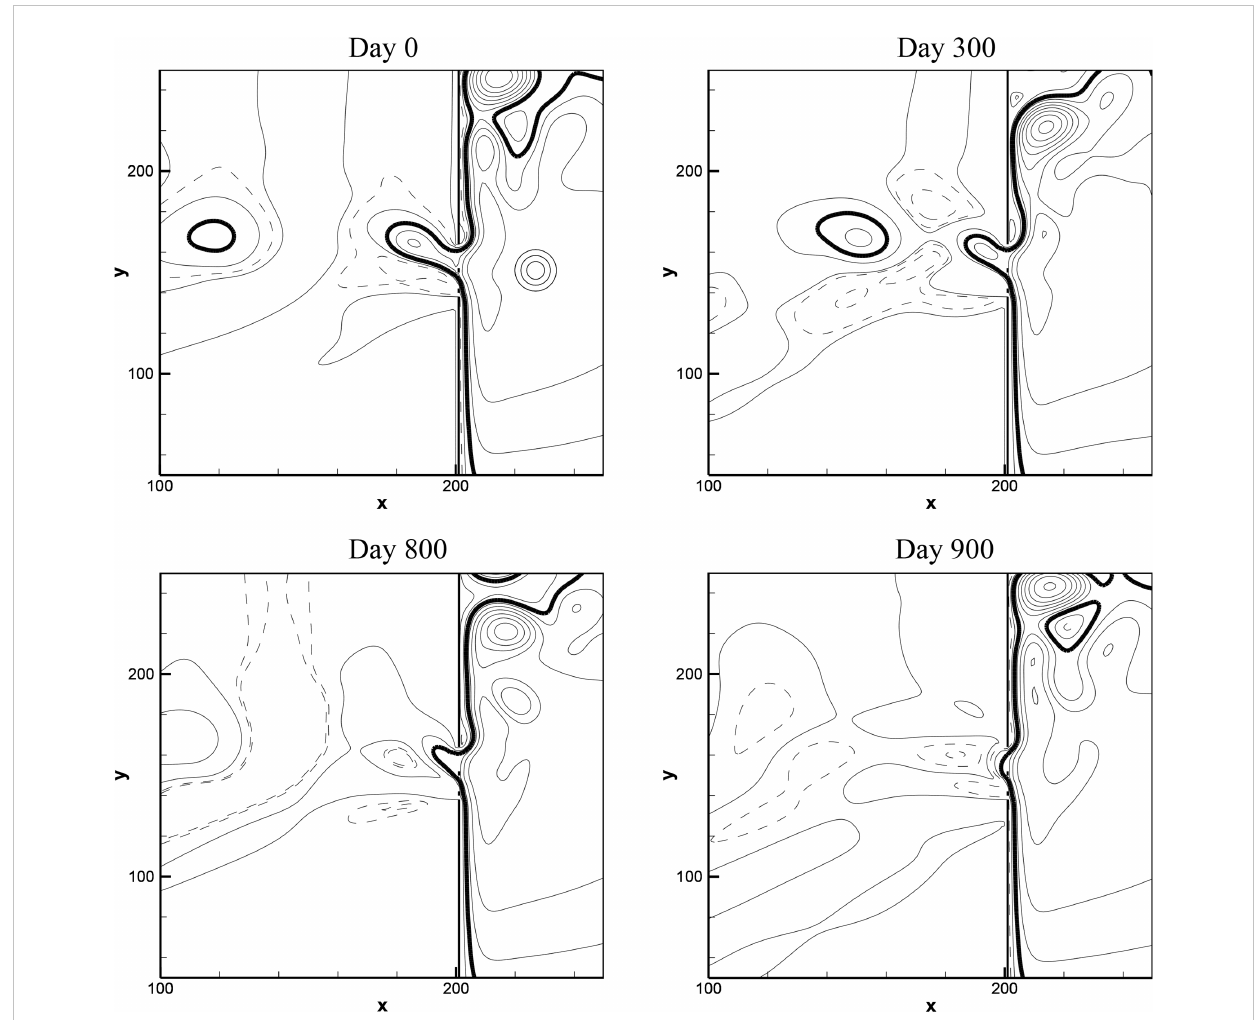
FIGURE 6 Same as Figure 4, except for the critical WBC pattern impinged by a cyclonic eddy. The critical strength of the eddy is y c = 28,000 m 2 s − 1 . WBC, western boundary